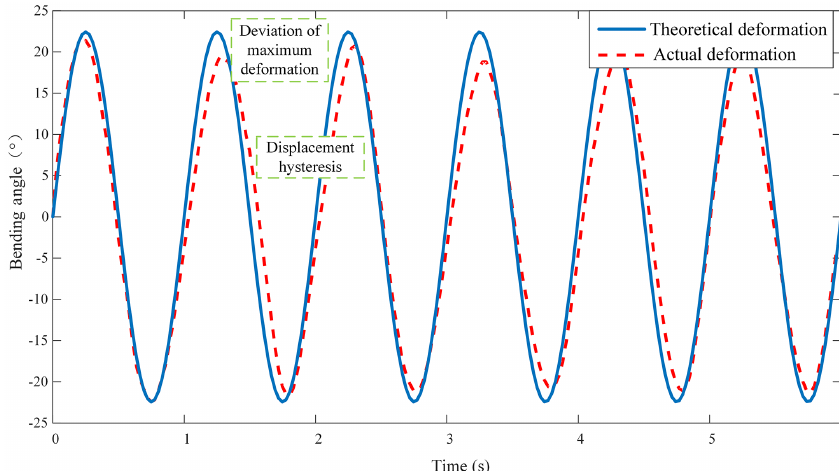
Figure 6. Dynamic experimental results under sinusoidal signal.